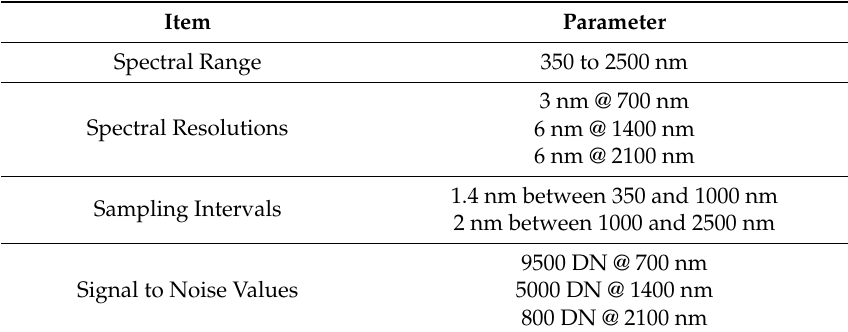
Table 3. Technical specifications of the ASD Inc. TerraSpec ®